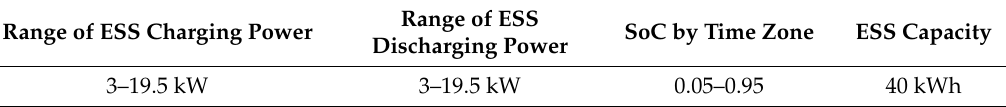
Table 3. Basic setting for the simulation.